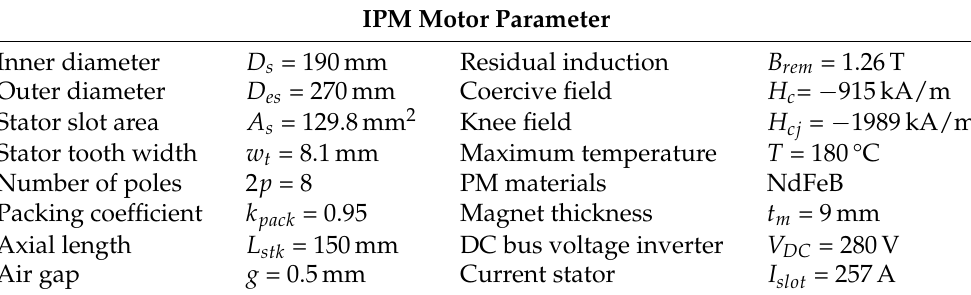
Table 2. IPM Motor